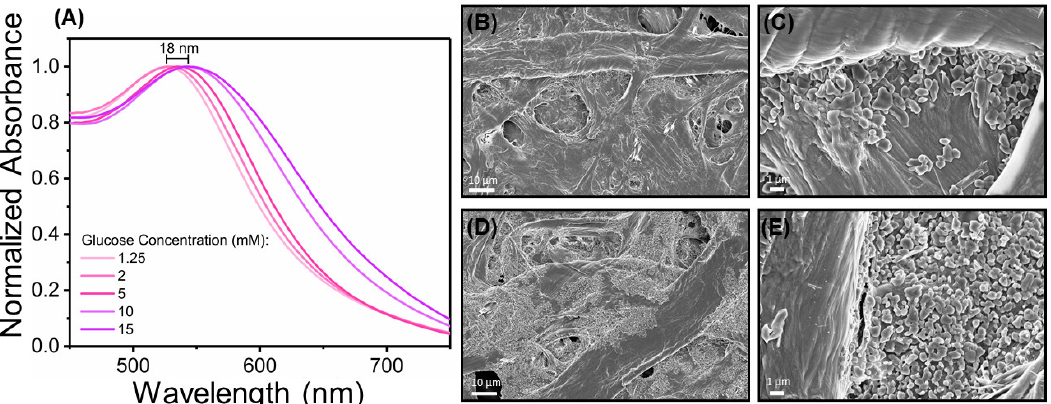
Figure 6. Optical and morphological characterization of in-situ synthesized AuNPs. ( A ) Absorbance measurements of paper substrate with AuNPs synthesized using different glucose concentrations, showing a red-shift associated with glucose increase. ( B , C ) SEM images of AuNPs synthesized using 2 mM glucose concentration. ( D , E ) SEM images of AuNPs synthesized using 15 mM glucose concentration.